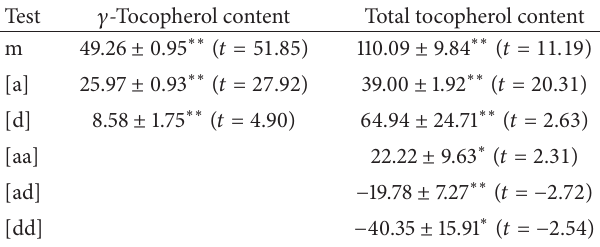
Table 2: Individual scaling tests 𝐴 , 𝐵 , and 𝐶 for 𝛾 -tocopherol content and total tocopherol content in the cross between the Ethiopian mustard lines BCT-6, with reduced 𝛾 -tocopherol content, and C-101, with conventional levels of 𝛾 -tocopherol.